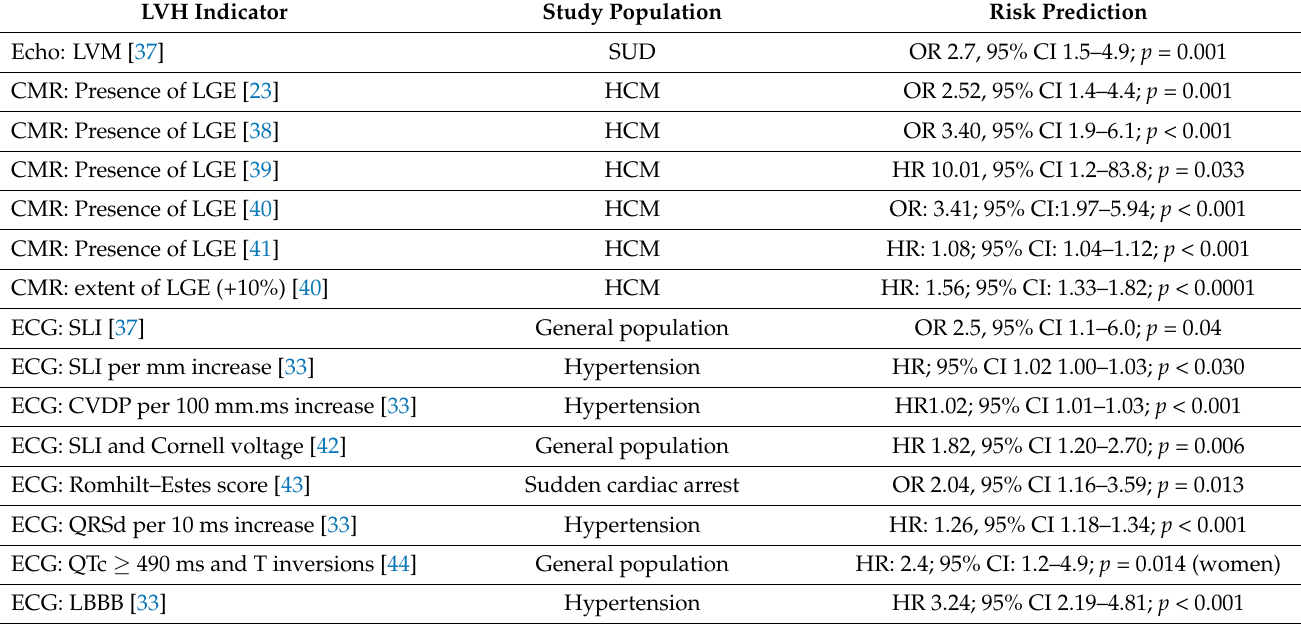
Table 2. The predictive value of echocardiographic, CMR, and ECG LVH indicators for the develop- ment of ventricular arrhythmias/sudden cardiac death. LVH Indicator Study Population Risk